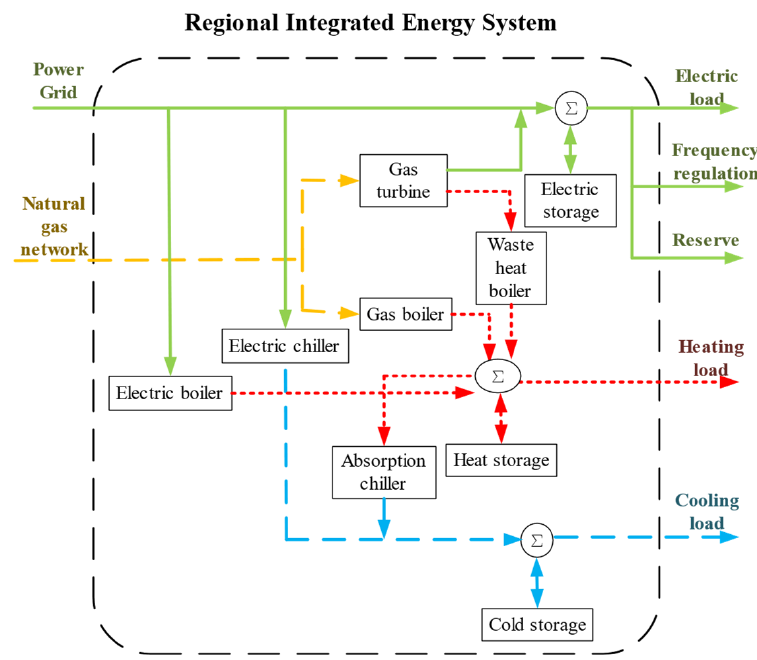
Figure 2. Structure of the RIES.